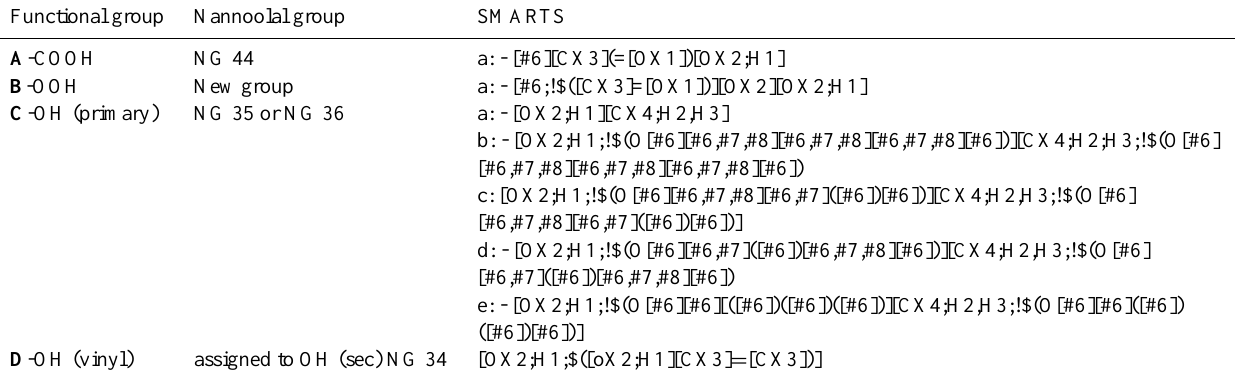
Table 3. SMARTS for Nanoolal groups, as copied from the Supplement of Barley et al. (2011). Functional